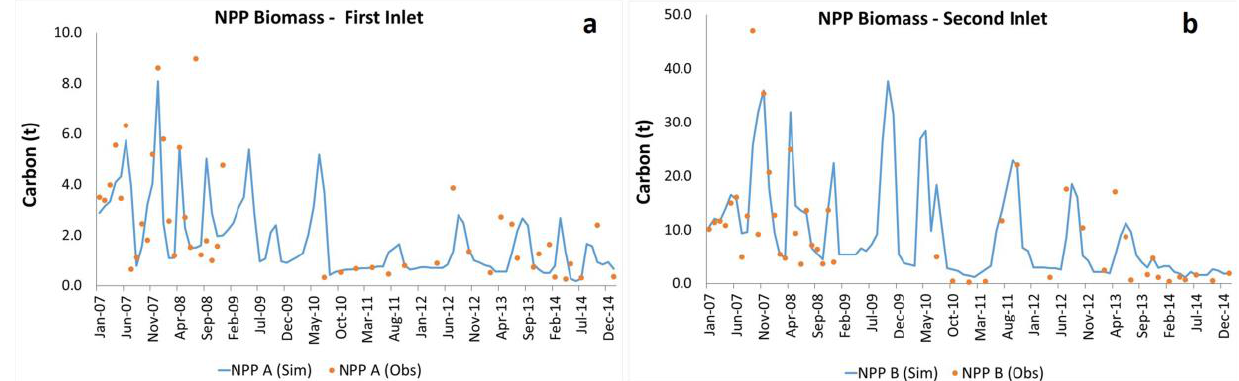
Figure 5. Nano-Phytoplankton (NNP) biomass (t of Carbon) simulated (line) and field data (dots) in the First Inlet ( a ) and in the Second Inlet ( b ) of Mar Piccolo. PPP biomass was usually negligible (on average up 21.8% of TPB), except in summer when they reached the maximum value of 92.5 µ g C L − 1 , representing up to 47.5% of TPB (September 2007, SI) (Figure 6).